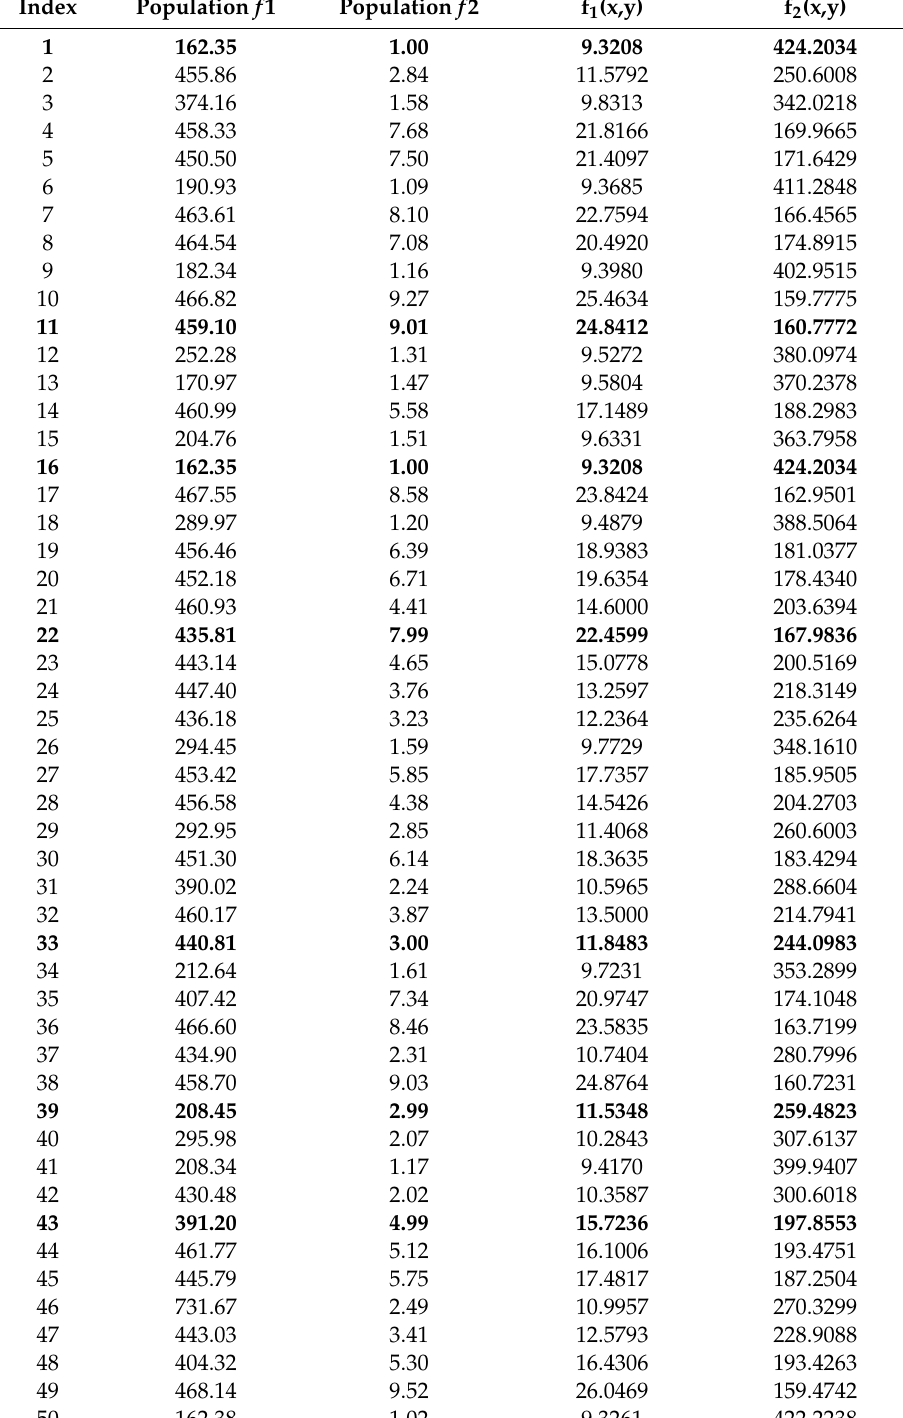
Table 5. Data collected from previous multi-objective